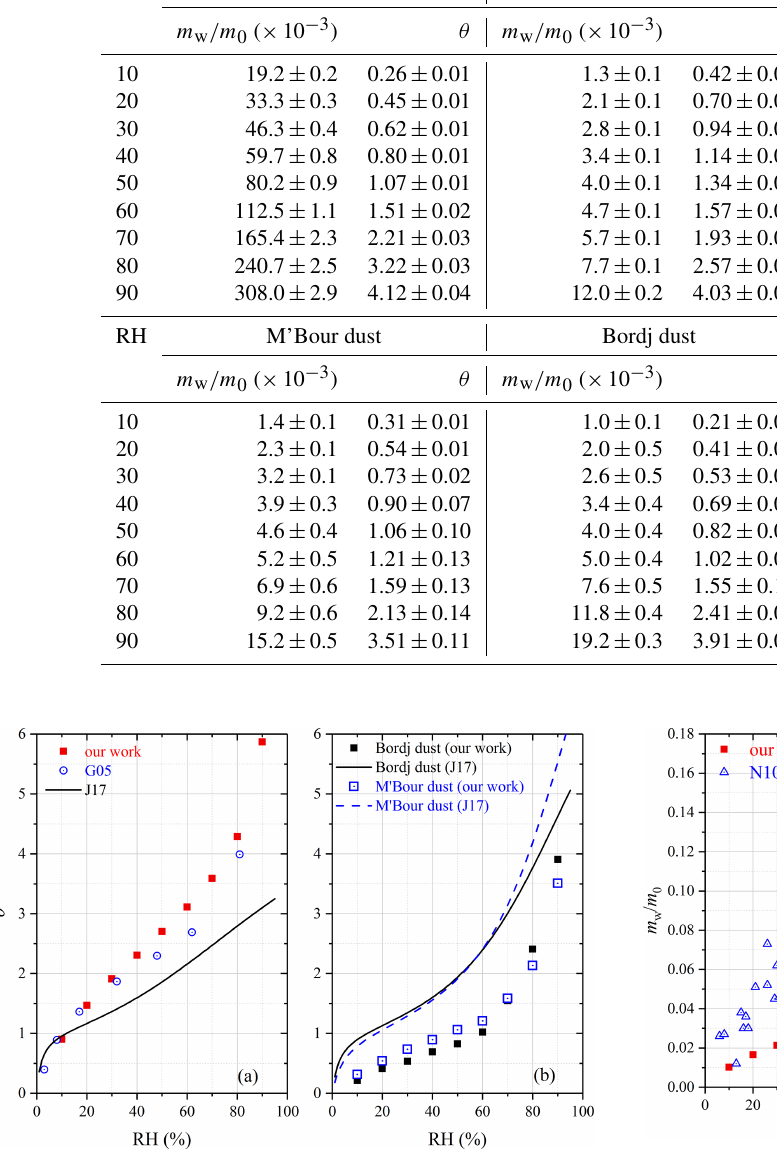
Table 4. Mass ratio of adsorbed water to the dry mineral ( m w /m 0 ) and surface coverages of adsorbed water ( θ ) as a function of RH (%) for montmorillonite, chlorite, ATD, M’Bour dust, Bordj dust and Saharan dust. RH Montmorillonite